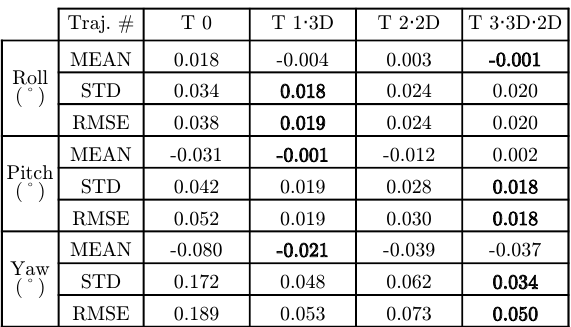
Table 2. Error statistics of the estimated trajectories. The best trajectory for each metric (line) is highlighted in bold.